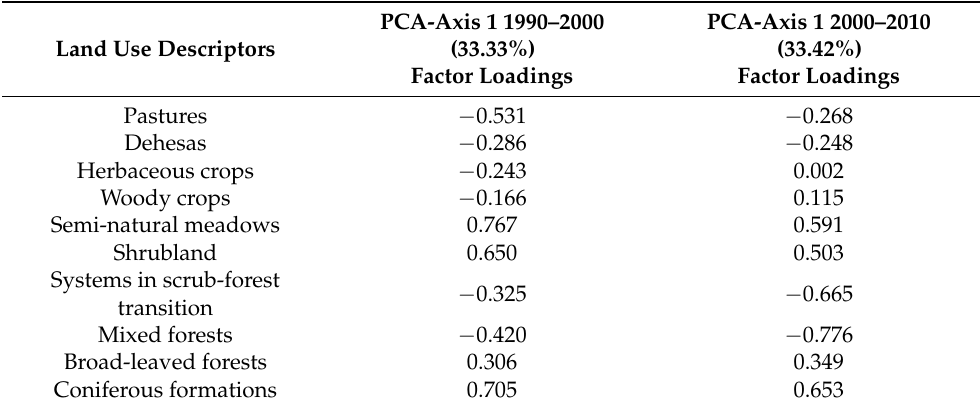
Table 2. Factor loadings of the land use descriptors on PCAs-Axes 1 of the analysed two periods (variance absorptions are shown in brackets). Loadings of the variables identified as key indicators of the cultural landscape over time are indicated in italics (see Figure